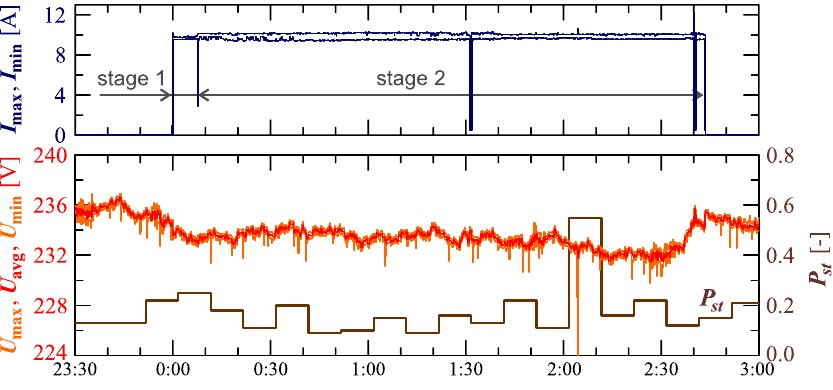
Figure 14. The characteristics of maximum U max = f ( t ) , average U avg = f ( t ) , and minimum U min = f ( t ) values of rms values of the supply voltage and characteristic P st = f ( t ) for Case